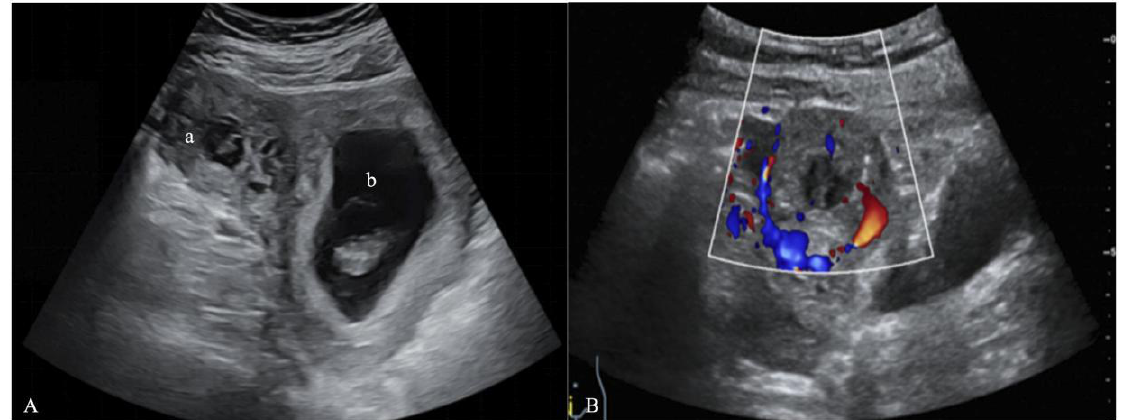
Figure 1. Ultrasound images on the 38th day after ET. ( A ) A two-dimensional ultrasound image: (a) the interstitial gestational sac in the interstitium of the right fallopian tube and (b) the intrauterine gestational sac. ( B ) A color Doppler ultrasound image showing an abundant blood flow signal around the IP.